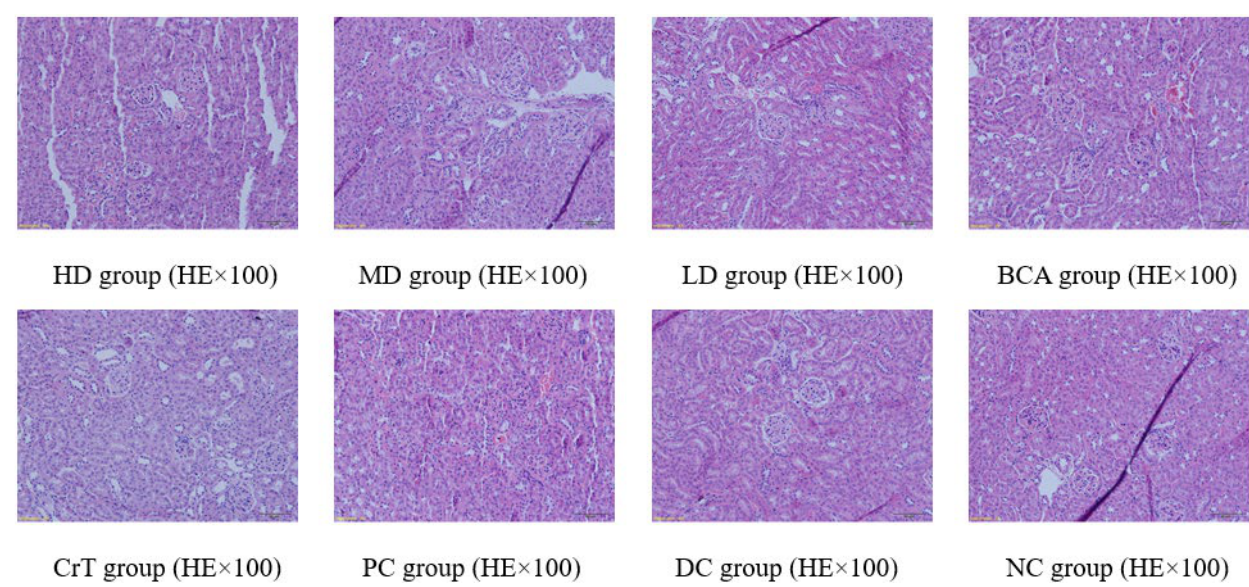
Figure 12. Morphological changes in renal tissue.